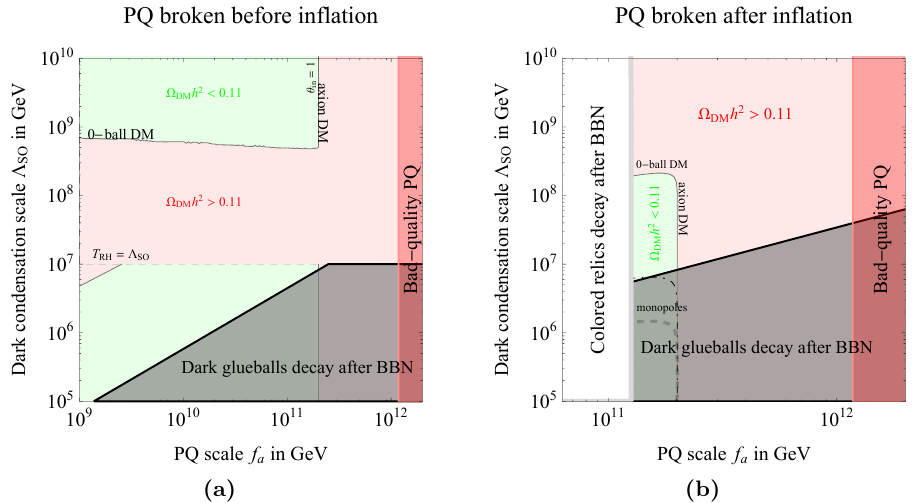
Figure 5 . Allowed regions in the ( f a , Λ SO ) plane for the SU(14) model with a scalar in the symmetric, assuming y Q = 1 , y L = 0 . 1 , Y L = 0 , Y Q = − 1 / 3 . DM is composed by axions and 0- balls. The relic DM abundance is reproduced along the boundaries between the red/green regions. White (gray) regions are excluded because Q (dark glue-balls) decay after BBN. The region at large f a is disfavoured by poor PQ quality, eq. (4.6). Left : we assume PQ-breaking before inflation with T RH = 10 7 GeV (cid:28) f a . The axion DM abundance is computed for θ in = 1 . Right : PQ- breaking after inflation. We assumed that monopoles decay; otherwise they contribute as well to the DM density and the curve along which the DM abundance is reproduced becomes the dashed curve (Kibble-Zurek estimate) or the dot-dashed curve (Kibble-Zurek plus an estimate of monopole